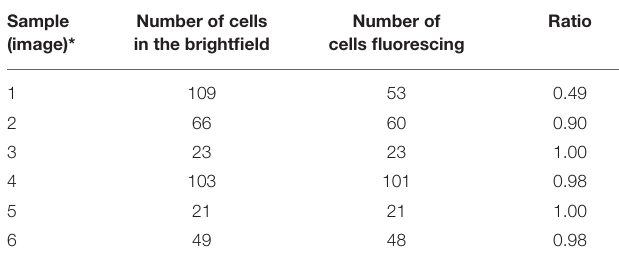
TABLE 2 | Quantification of Candida cells incubated with TMPyP. Sample (image)*